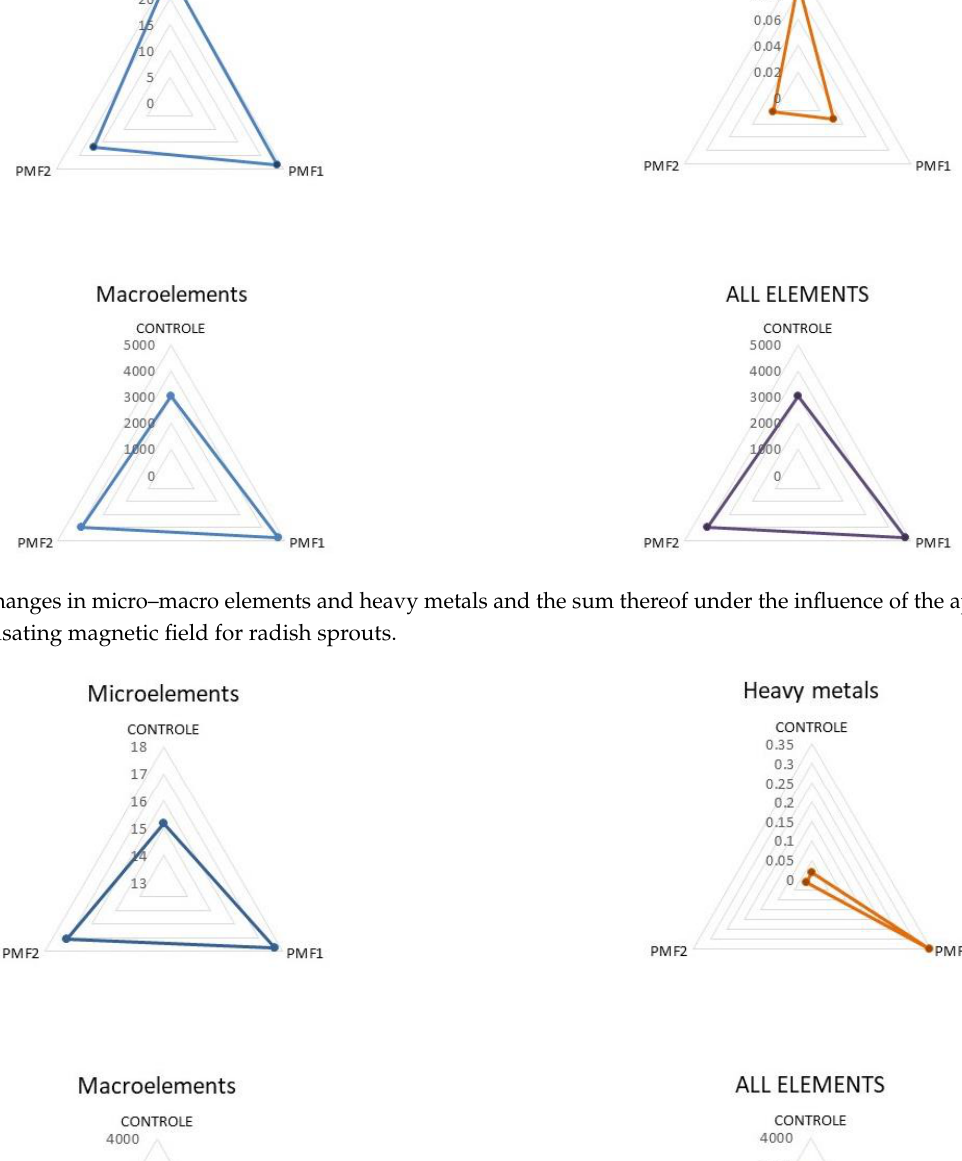
Figure 6. Changes in micro – macro elements and heavy metals and the sum thereof under the influ- ence of the application of doses of pulsating magnetic field for cress sprouts.